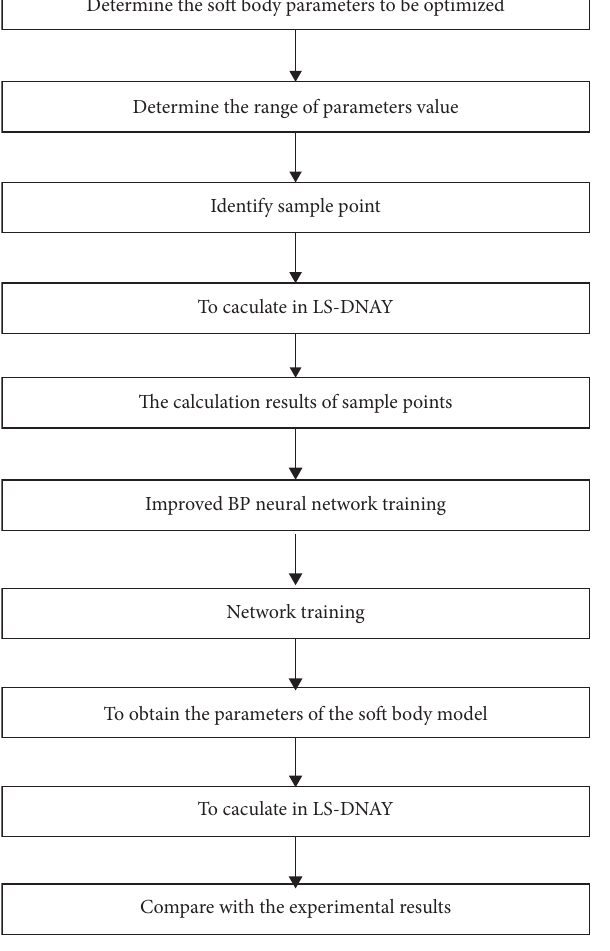
Figure 2: Flow chart of soft body parameter